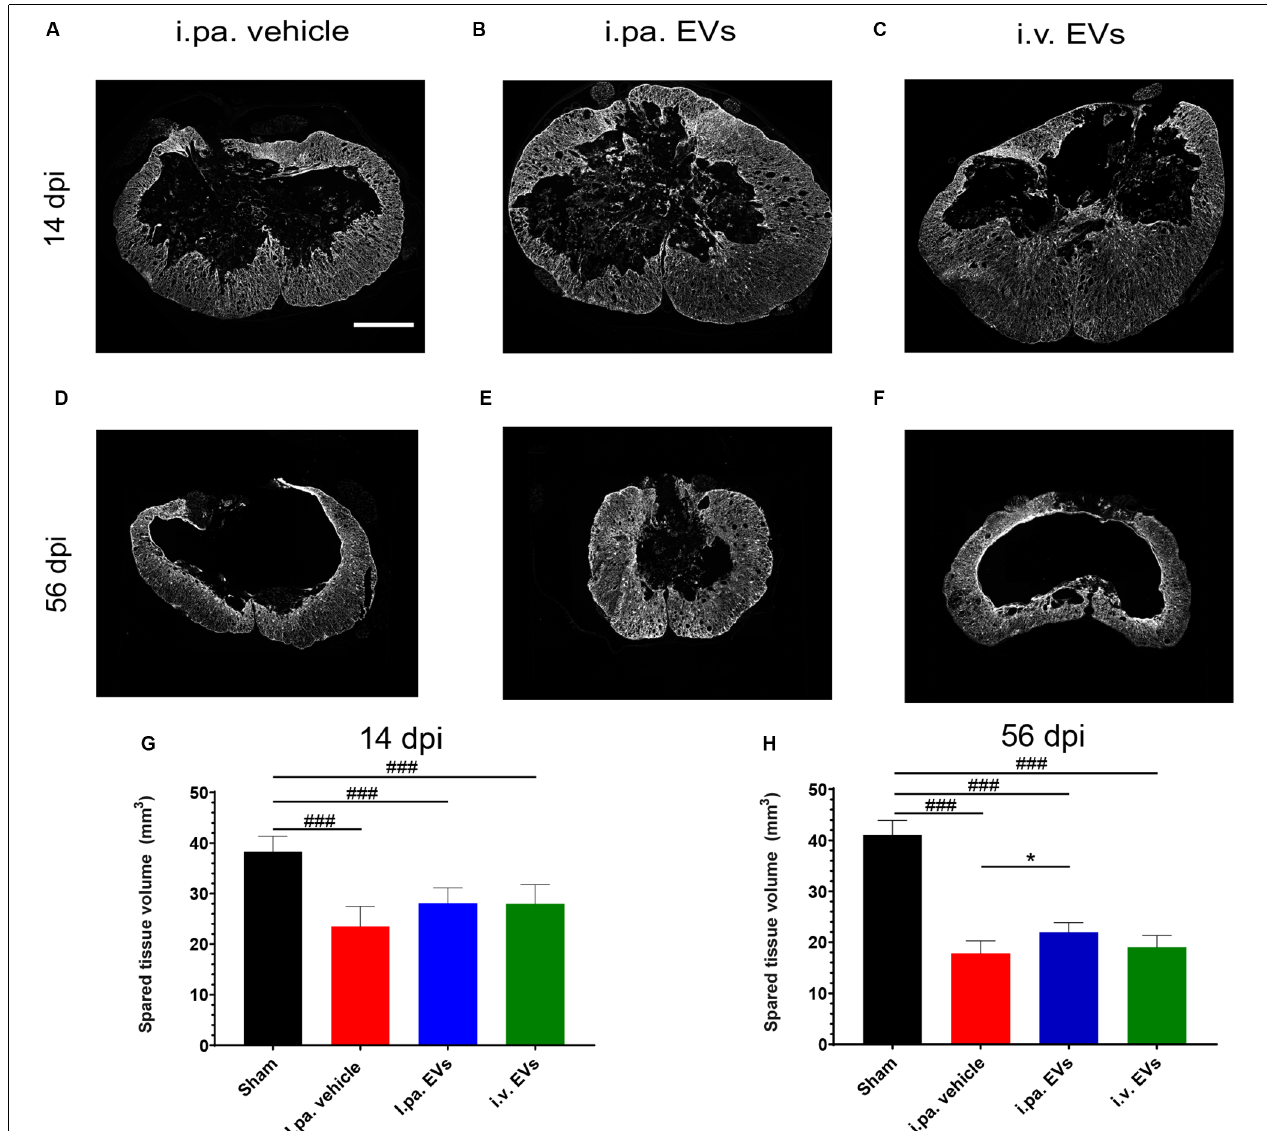
FIGURE 4 | Early intralesional application of EVs spared more parenchyma after tSCI. (A–F) Representative micrographs of GFAP immunodetection on spinal cord sections at lesion epicenter at 14 days (A–C) and at 56 days post-tSCI (D–F) . Scale bar = 500 µ m. The total volume of healthy-appearing parenchyma was calculated from 3 mm rostral to 3 mm caudal to the lesion epicenter, or the equivalent position in the sham rats at 14 days (G) and 56 days post-tSCI (H) . Statistical differences to sham group using one-way ANOVA and Tukey post hoc test: ( ### ) p < 0.001, statistical differences to i.pa. vehicle group using one-way ANOVA and Tukey post hoc test on tSCI groups (without sham): ( ∗ ) p < 0.05. Days post-injury: